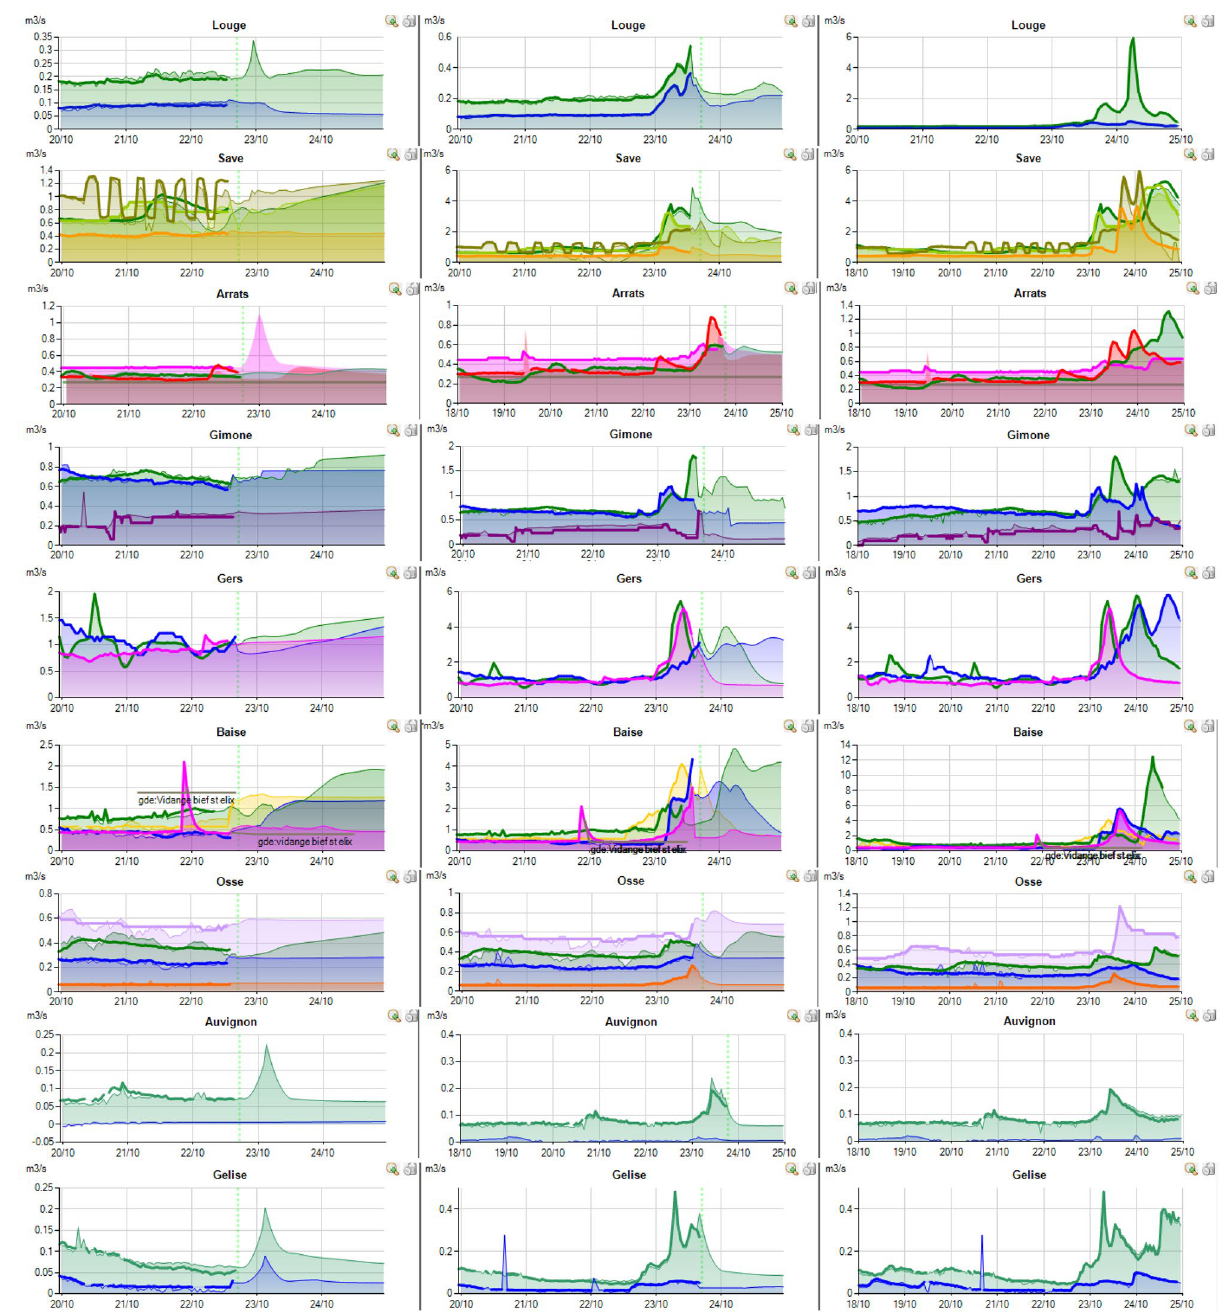
Figure 14. Left tributaries of the Garonne dashboards